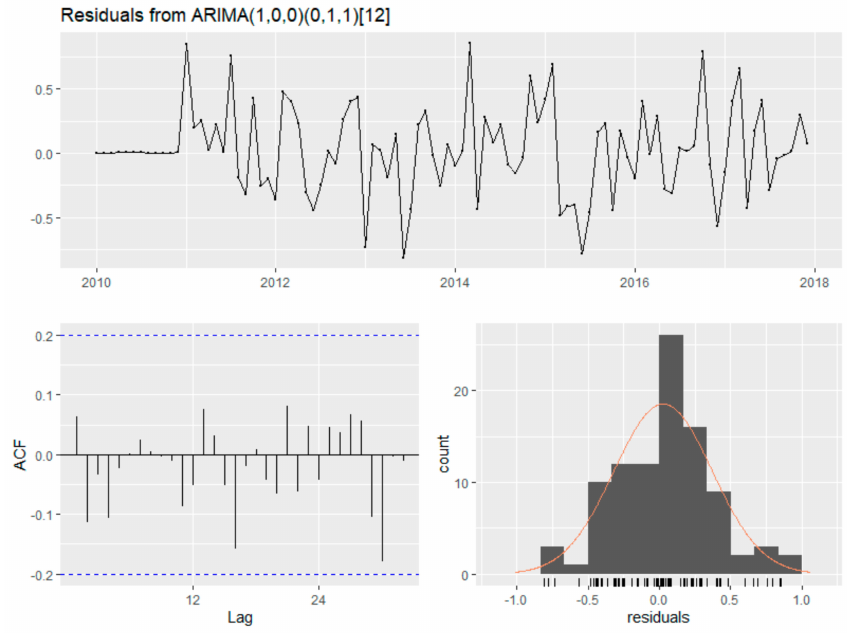
Figure 9. Residuals analysis for the ARIMA model.